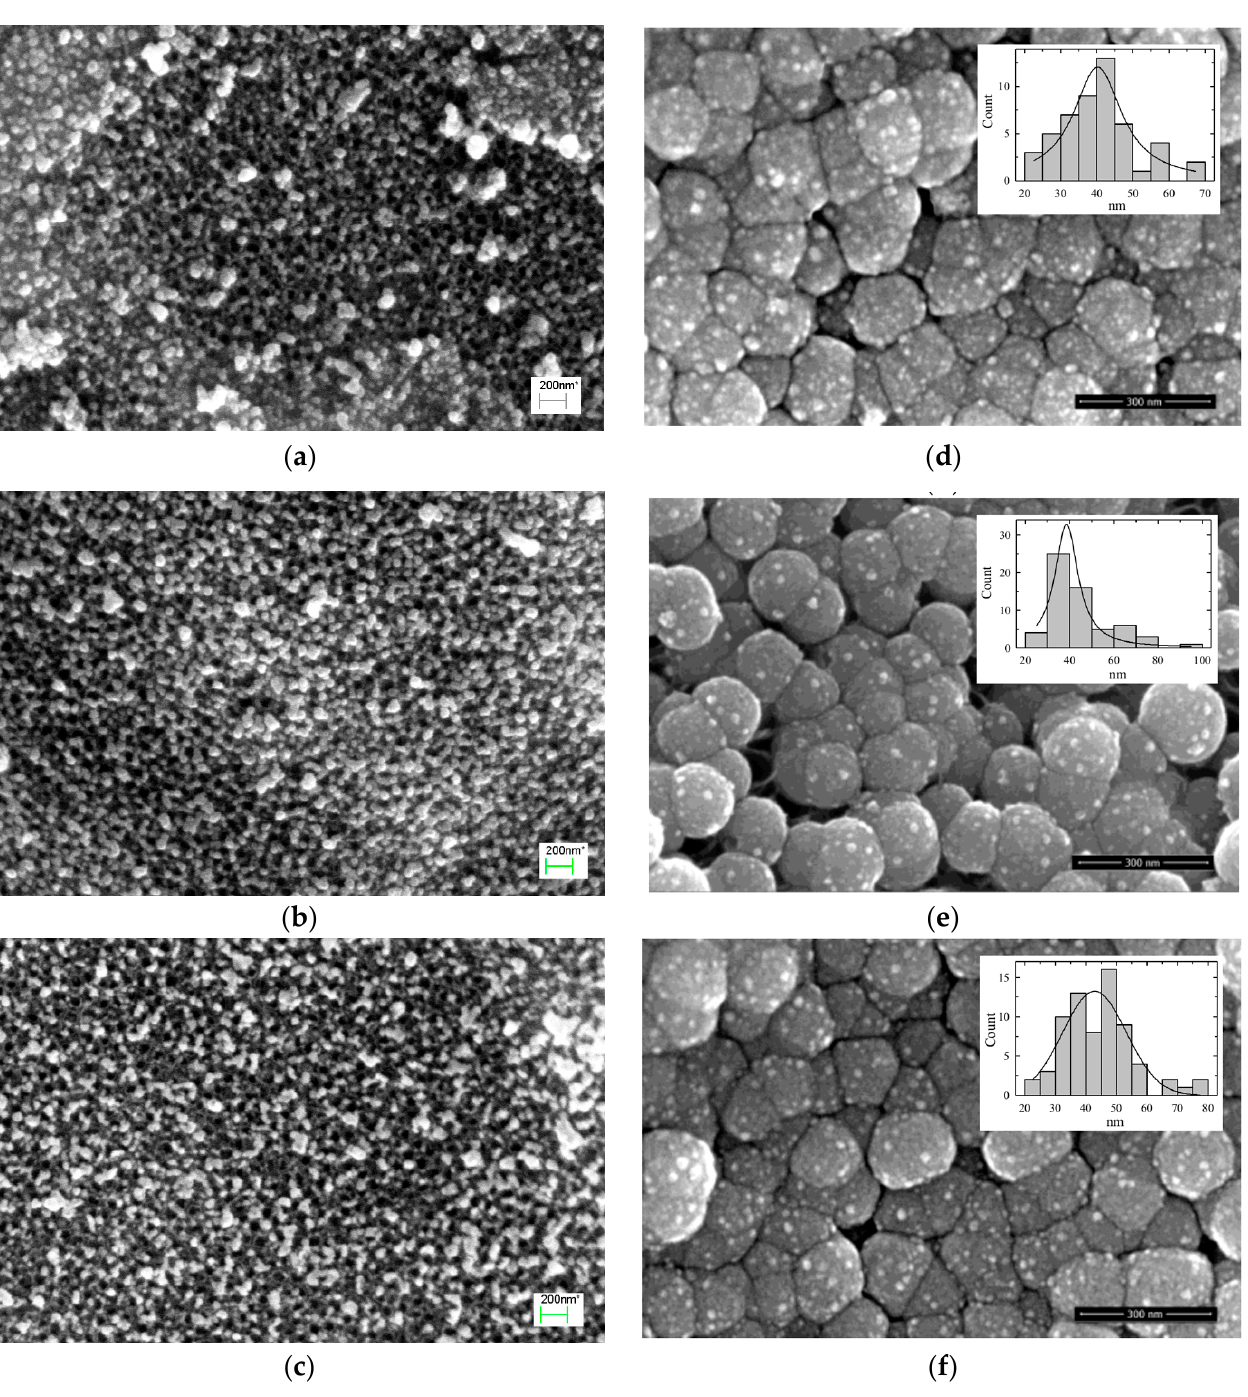
Figure 2. The surface morphology of: ( a – c ) AuNi-TiO 2 ntbs were fabricated by the dipping of TiO 2 ntb in the Ni plating solution operated at 85 °C for 5 s, followed by their dipping in Au-containing solution at 25 °C for ( a ) 60, ( b ) 300, and ( c ) 1800 s. ( d – f ) AuNi-TiO 2 ntb catalysts were fabricated by the dipping of TiO 2 ntb in the Ni plating solution operated at 85 °C for 20 s, followed by their dipping in the same Au plating solution at 25 °C for ( d ) 10, ( e ) 20, and ( f ) 60 s. The insets in ( d – f ) present the Au nanoparticle distribution.